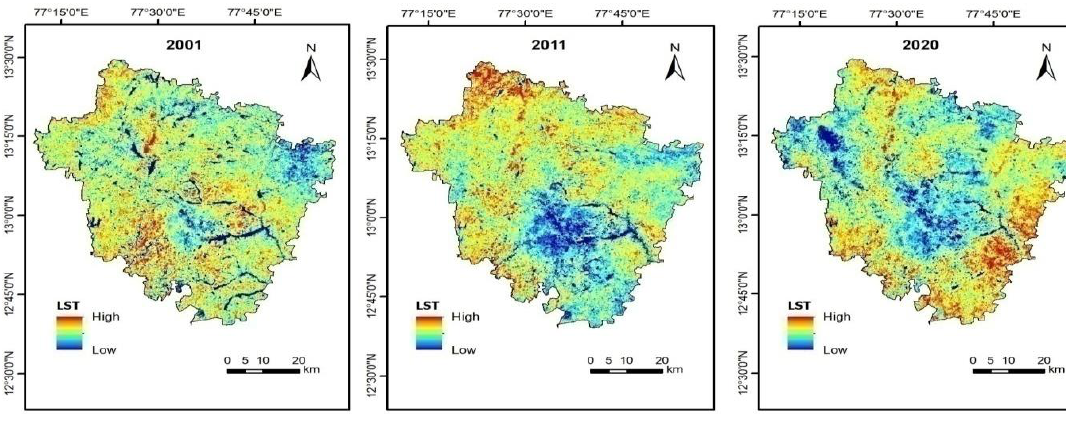
Figure 10. Spatio-temporal pattern of LST in Bengaluru.